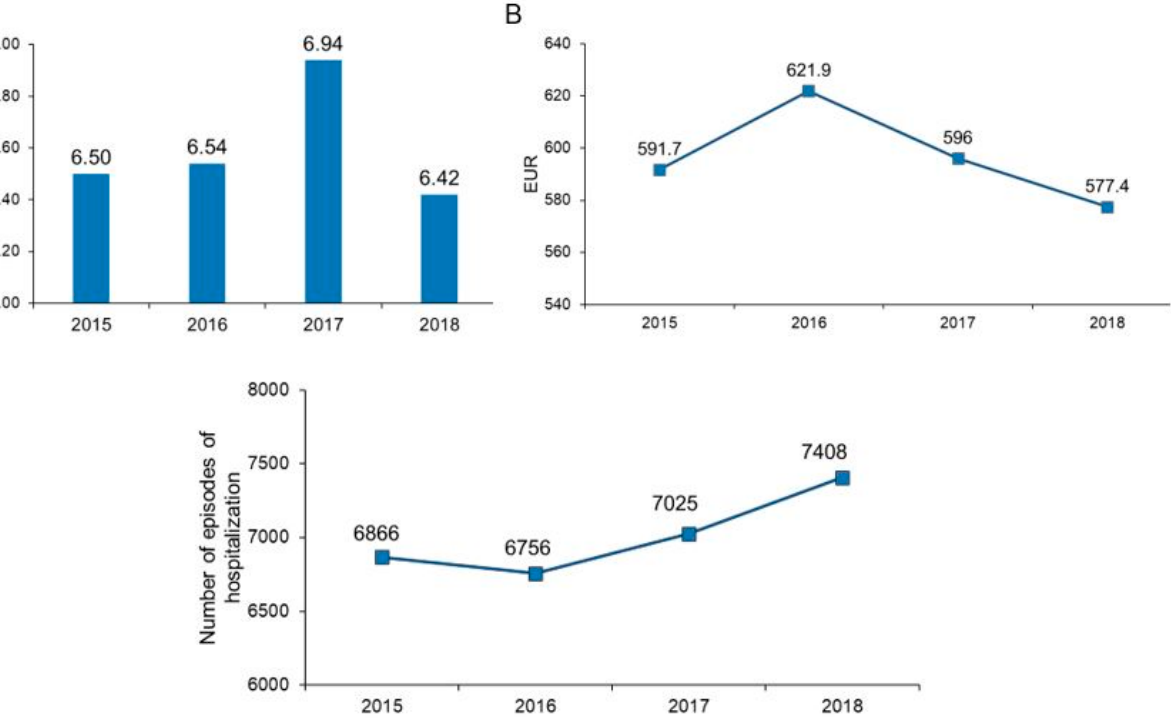
Figure 1. Evolution of total costs panel ( A ), median cost/episode of hospitalization panel ( B ), and the number of episodes of hospitalization in the studied period panel ( C ).